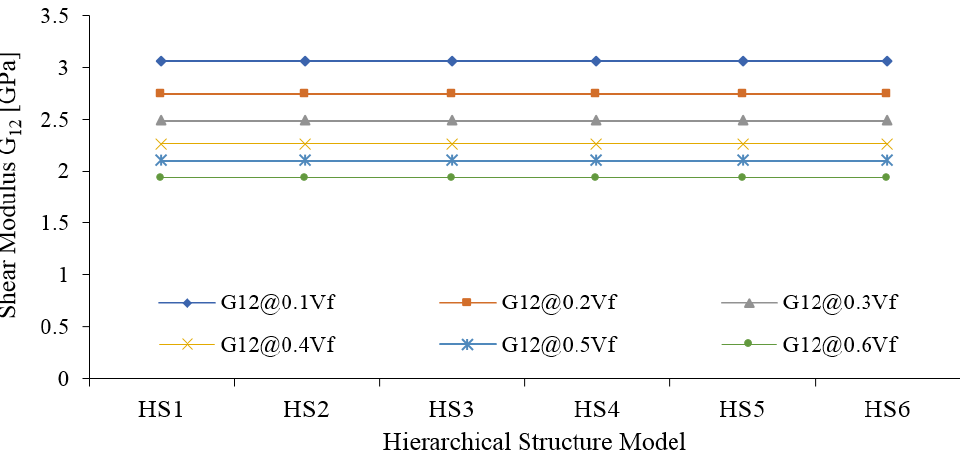
Figure 12. In-plane shear modulus (G 12 ) of Jute fiber composites. The out-of-plane shear modulus G 23 is influenced by the type of HS of JF, especially at volume fractions of 0.6, 0.5, 0.4, and 0.3 of JF (Figure 13). At lower volume fractions of JF, i.e., 0.1 and 0.2, no such changes are observed in the G 23